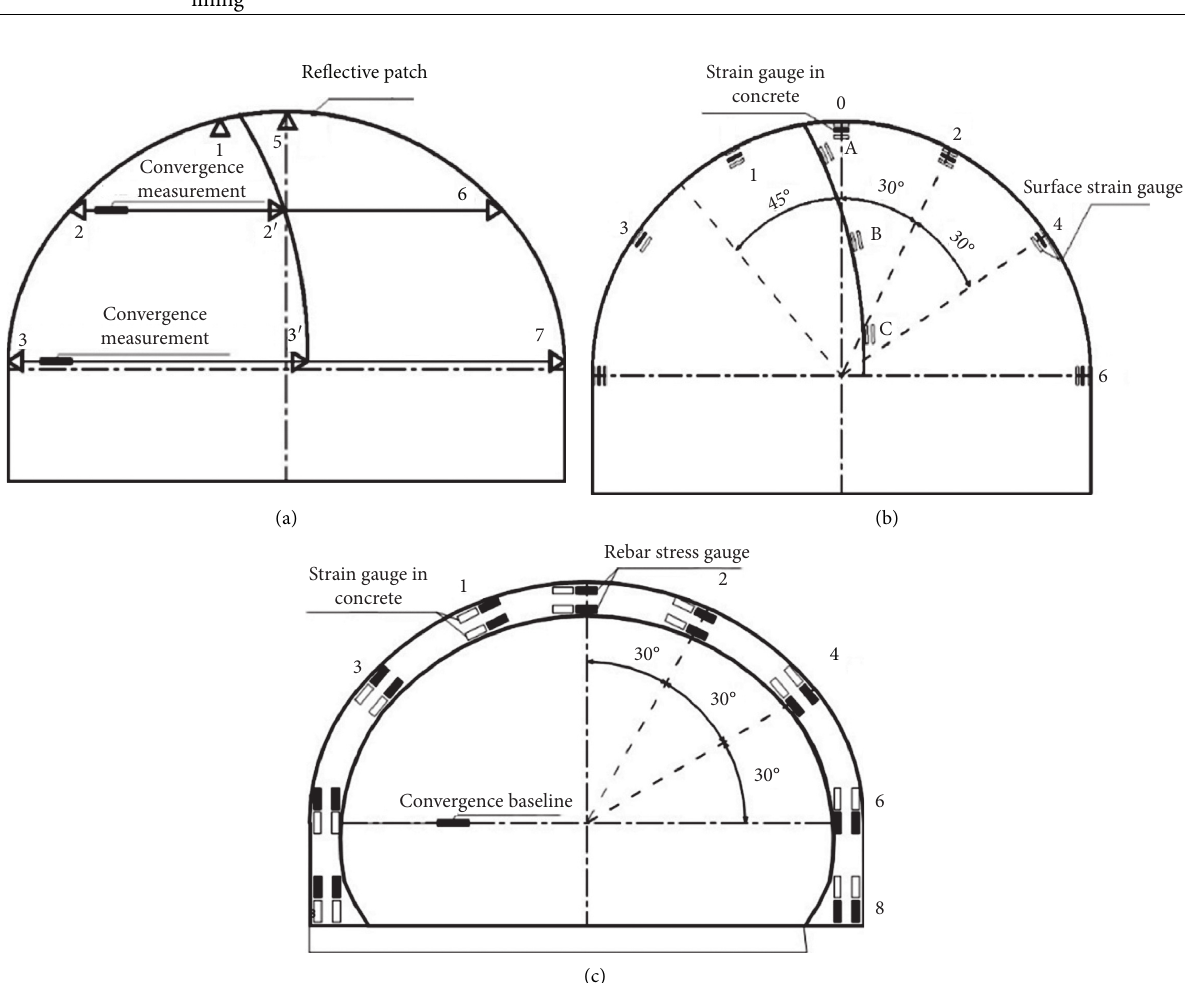
Figure 4: Layout of stress and deformation measuring points. (a) Layout of deformation monitoring points. (b) Stress monitoring points for primary support. (c) Stress monitoring points for secondary lining.